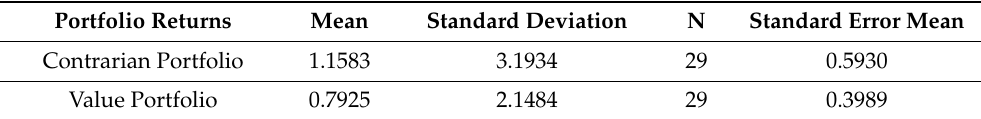
Table 4. Descriptive statistics of contrarian and value portfolio returns for year t + 1.